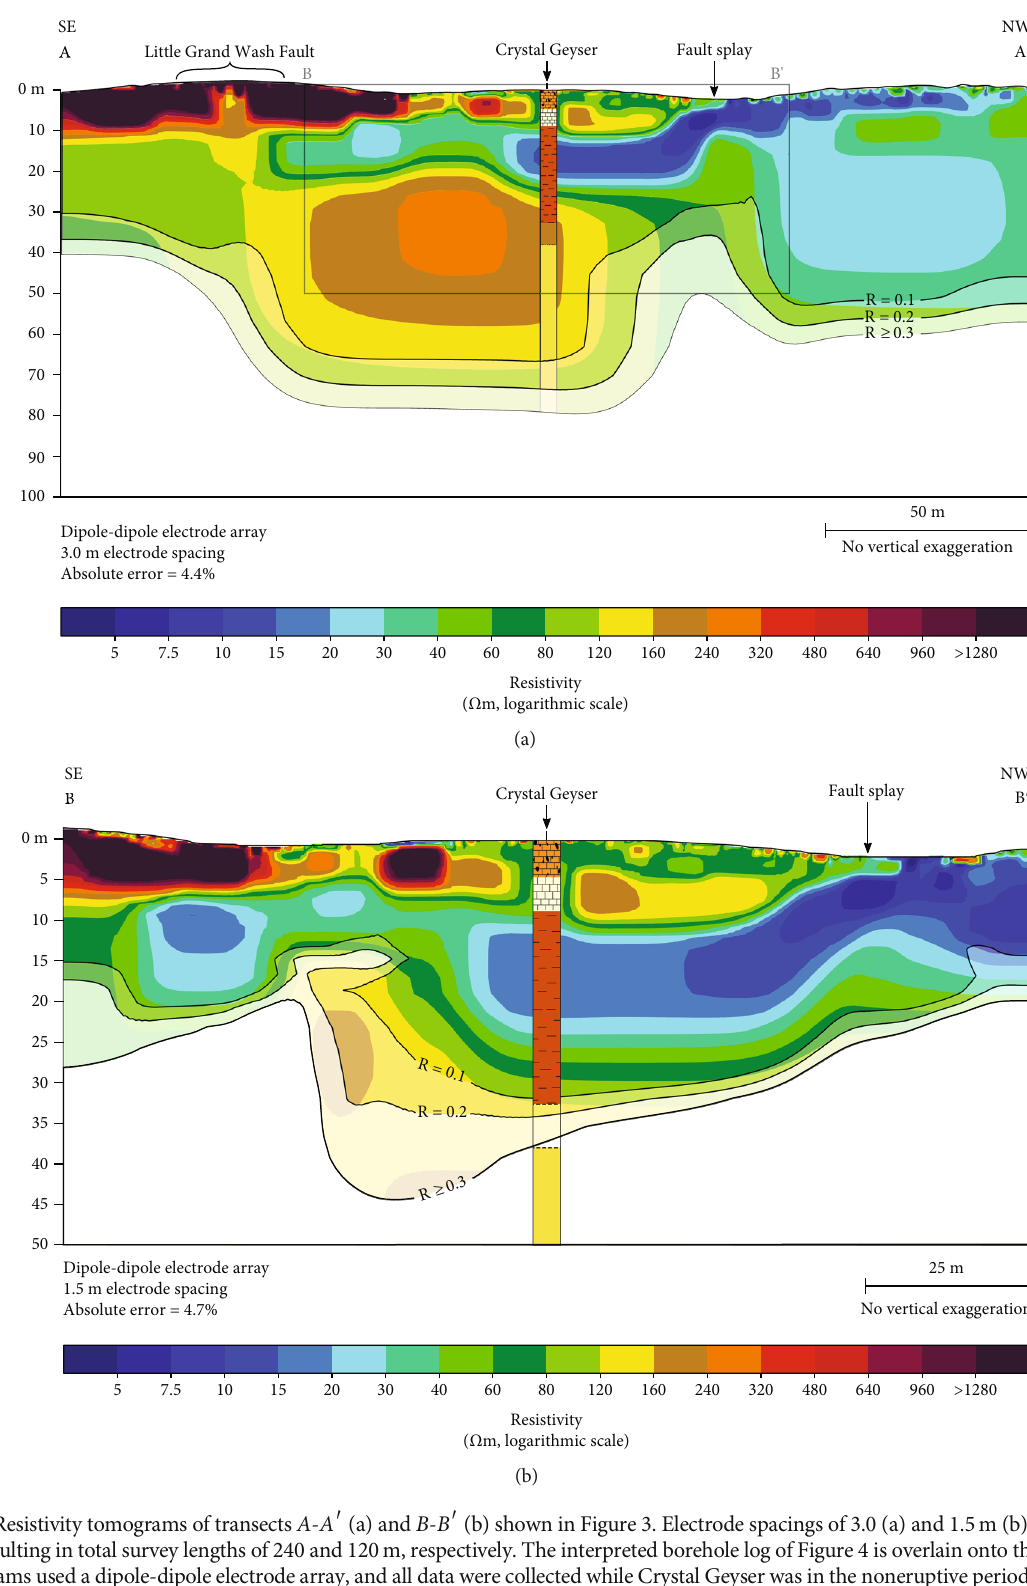
Figure 5: Resistivity tomograms of transects A ‐ A ′ (a) and B ‐ B ′ (b) shown in Figure 3. Electrode spacings of 3.0 (a) and 1.5m (b) were used for surveys, resulting in total survey lengths of 240 and 120m, respectively. The interpreted borehole log of Figure 4 is overlain onto the tomograms. All tomograms used a dipole-dipole electrode array, and all data were collected while Crystal Geyser was in the noneruptive period. The absolute errors of the fourth iteration are indicated. The depth datum is the ground surface at Crystal Geyser ( depth = 0 m). A DOI index ð R Þ < 0 : 1 to 0.2 indicates reliable areas of an image that are well constrained by the data. The area of (b) is indicated in (a) with a grey